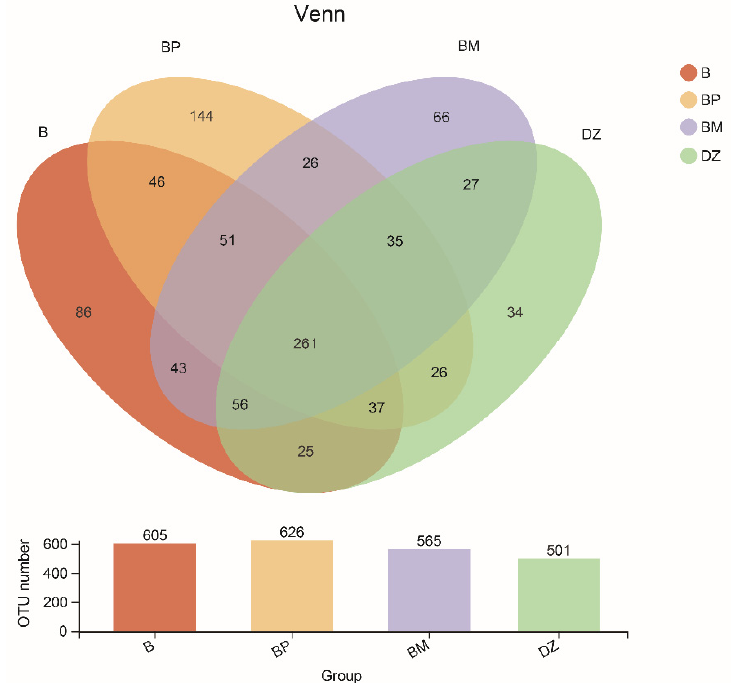
Figure 5. Venn diagram based on OTU level for different P. vannamei culture systems. Note: group B, a single B. pumilus BP-171, was added; the group BP, B. pumilus BP-171, and PHBV were added; the group BM, B. pumilus BP-171, and molasses were added; the group DZ, the control without any probiotics and carbon sources addition.